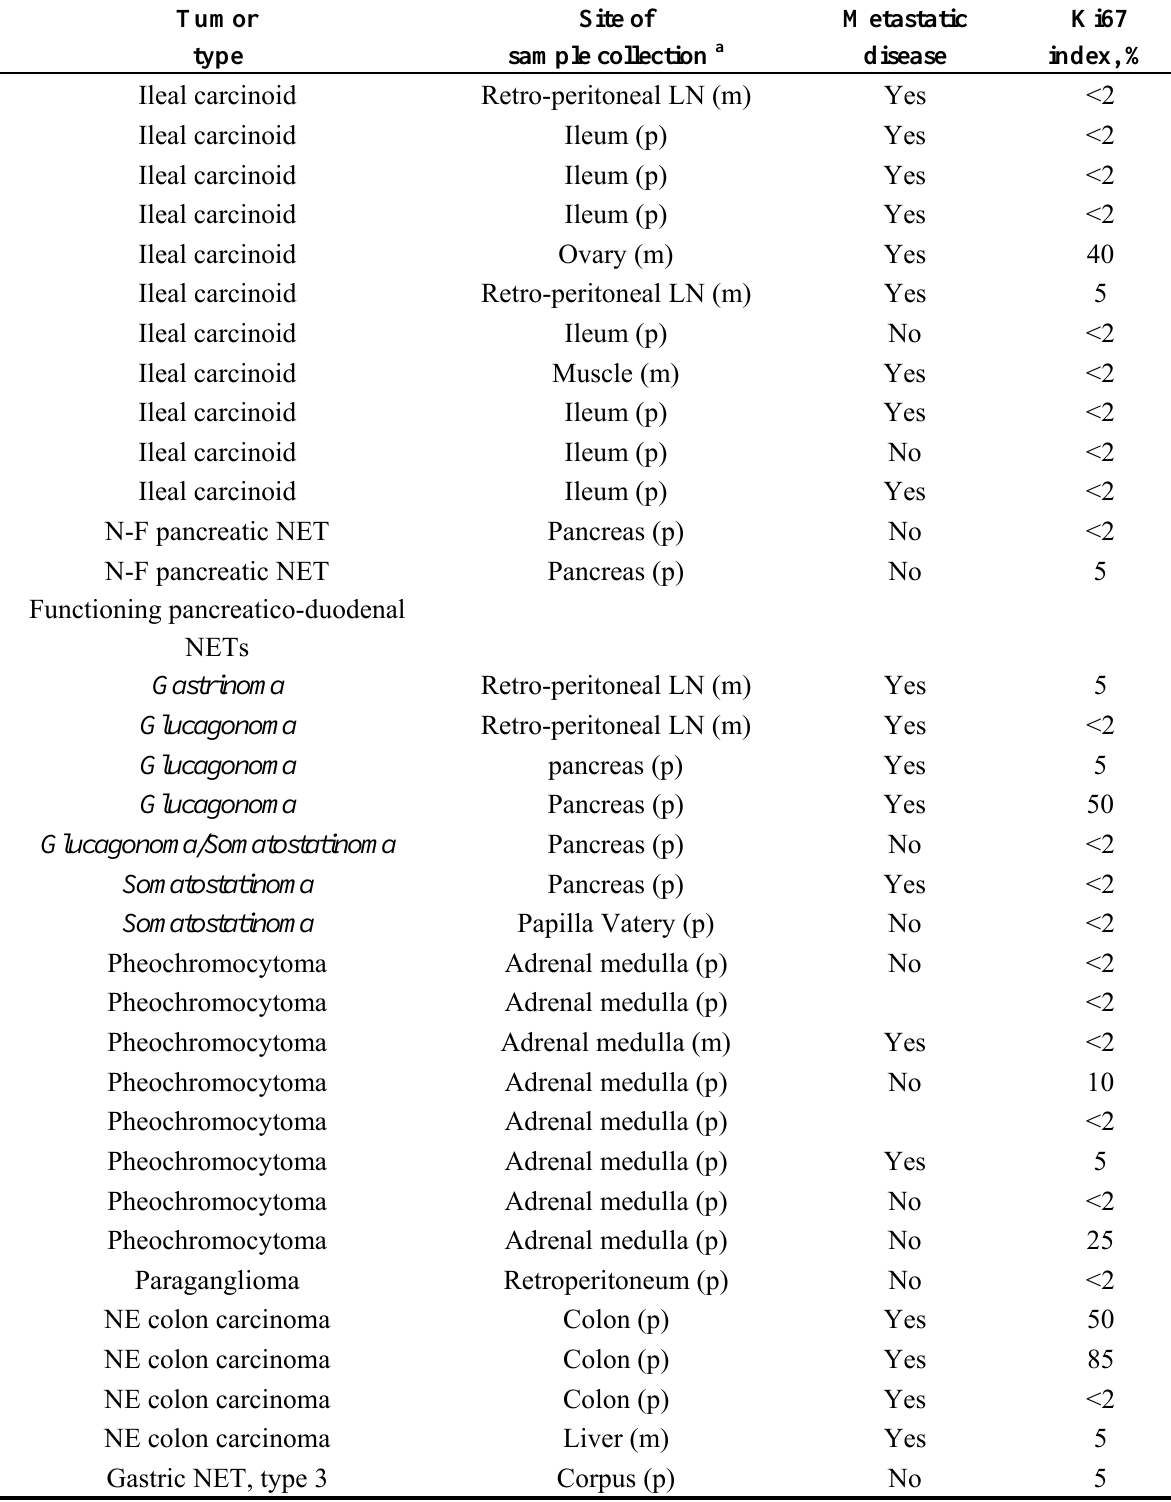
Table 1. Patient descriptions (neuroendocrine tumor (NET)